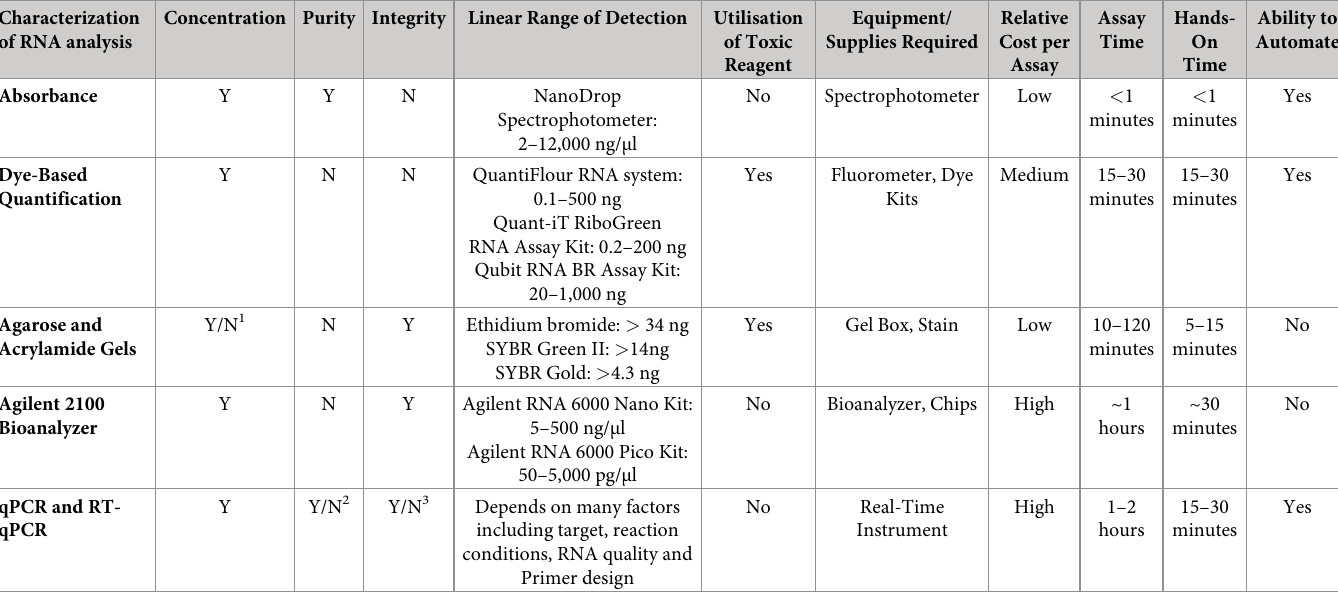
Table 1. Summary of analysis to characterise RNA quantity, quality and integrity. Characterization Concentration Purity Integrity Linear Range of of RNA analysis